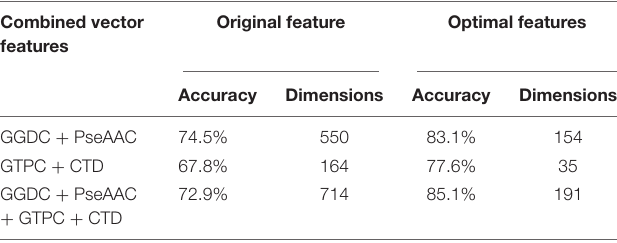
TABLE 1 | The results by using different features for phage enzymes prediction.